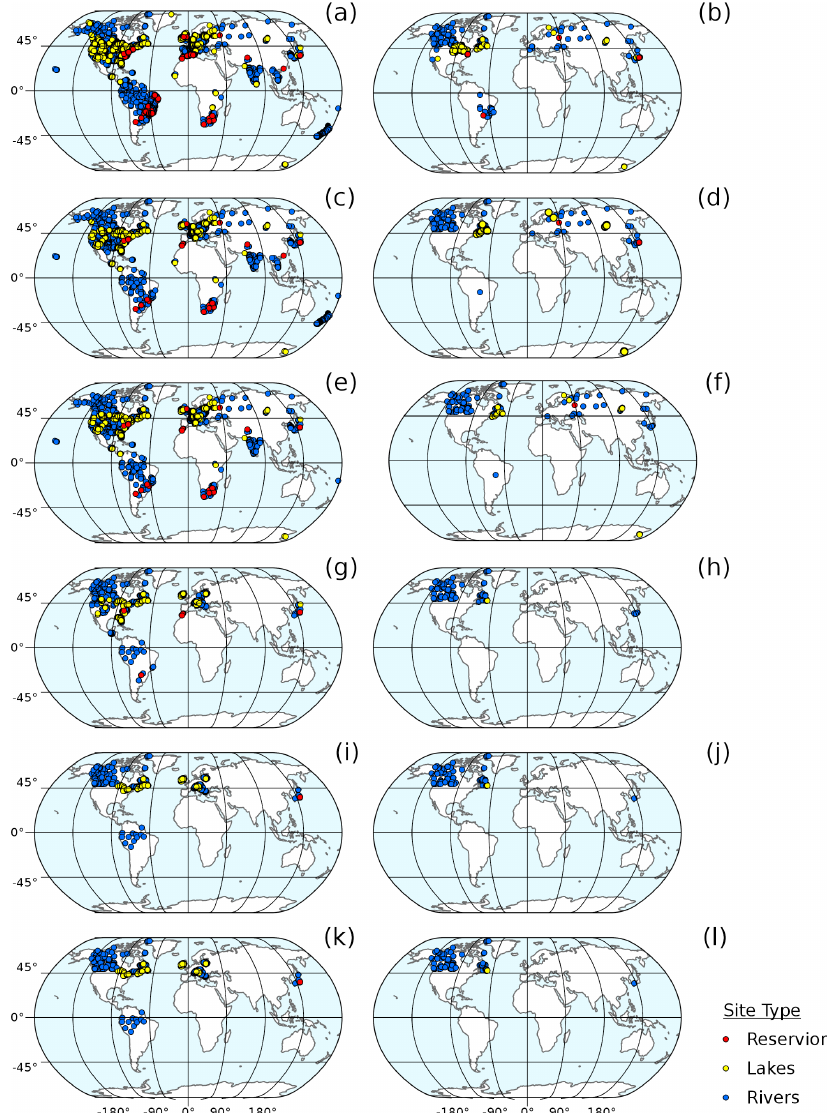
Figure 3. Sample size (sites) for waterbody types based on time series duration and data availability in the following parameter categories: acidity (a, b) , basicity (c, d) , acid anions (e, f) , metallic cations (g, h) , weak acids (i, j) , and other parameters (k, l) . Sites included in consecutive parameter categories also meet all of the prior category requirements. Sites with at least one observation are shown in the left panes, and sites with a minimum time series length of 15 years are shown in the right panes. Points overlap where sites are in close vicinity. Natural Earth projection is used, and the scale is 1 :